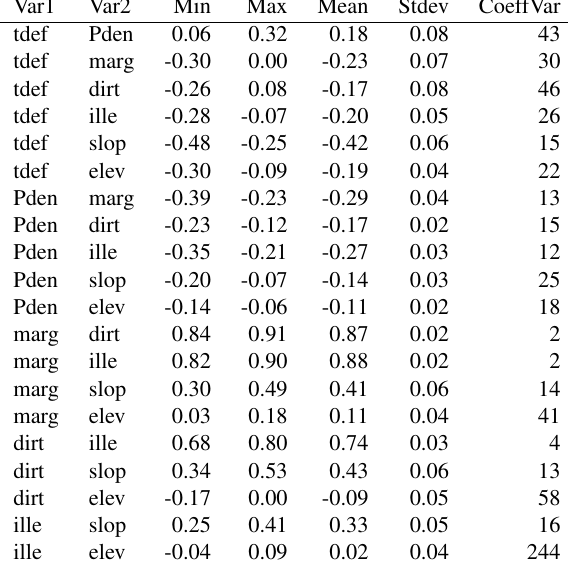
Table 5: Minimum, maximum, mean, standard deviation and co- efficient of variation of the values of the Pearson coefficient of correlation with 280 units (zoning effect)